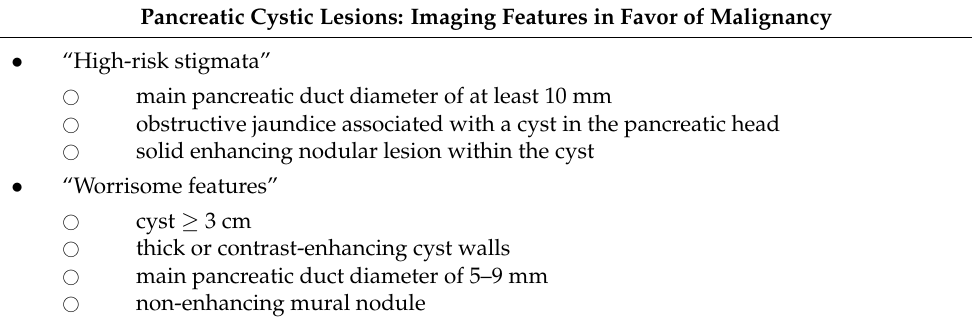
Table 3. Pancreatic Cystic Lesions: Imaging features in favor of